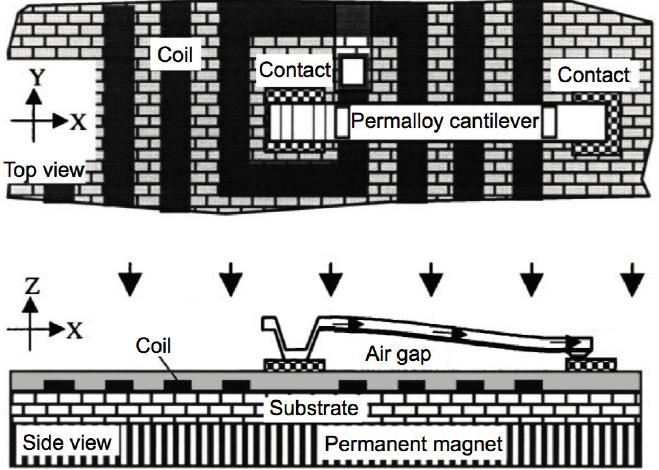
Figure 10. Top view ( top ) and cross-section ( bottom ) of the device proposed by Ruan et al. [78]. The device is mounted on a permanent magnet that provides the field needed for the operation. Reprinted with permission from [78], page 347. Copyright 2001 Elsevier.